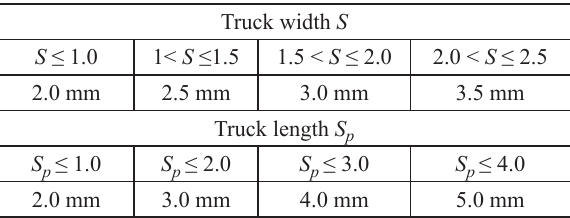
Table 9. Flatness tolerances across and along the driving track for a lift truck of the height of ≤6.0 m